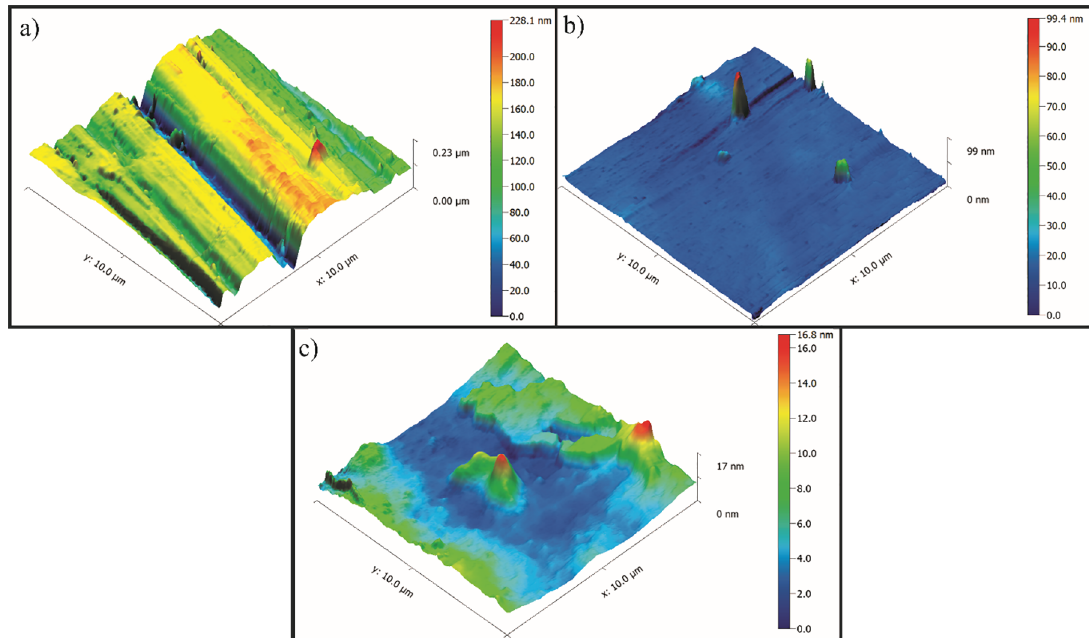
Figure 5. 3D images obtained through AFM of the surface of the studied samples: (a) 316L; (b) 316L_1 and (c) 316L_2. Table 3. Mean roughness values obtained through AFM analysis.